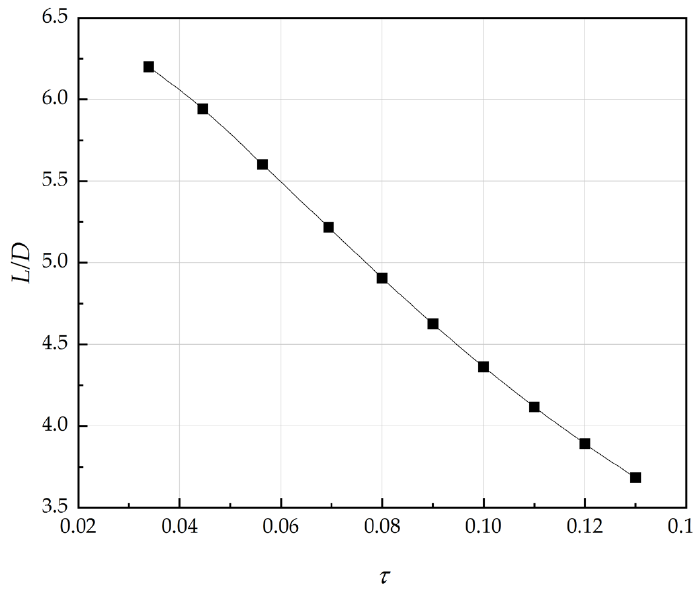
Figure 13. Maximum L/D variation with the Küchemann slenderness parameter, τ .